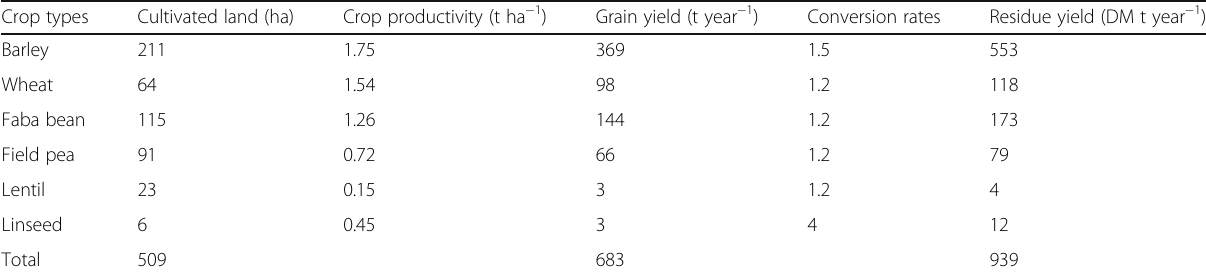
Table 3 Major cereal, legume and oil crops, and yield of crop residues in 2015/2016 cropping season Crop